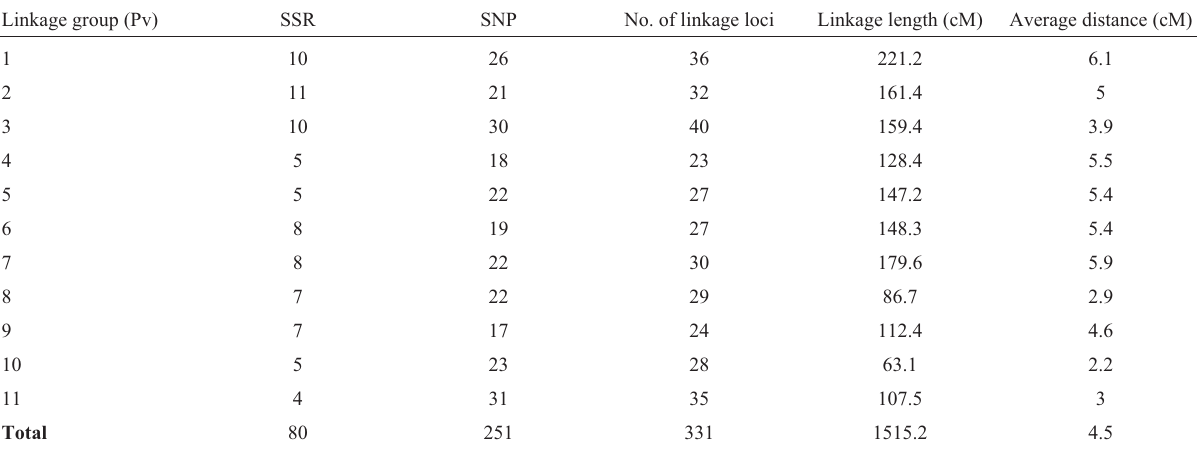
Table 1 - Distribution of SSRs and SNPs mapped in the 11 chromosomes of the common bean genetic map from the AND 277 x SEA 5 population. Linkage group (Pv)